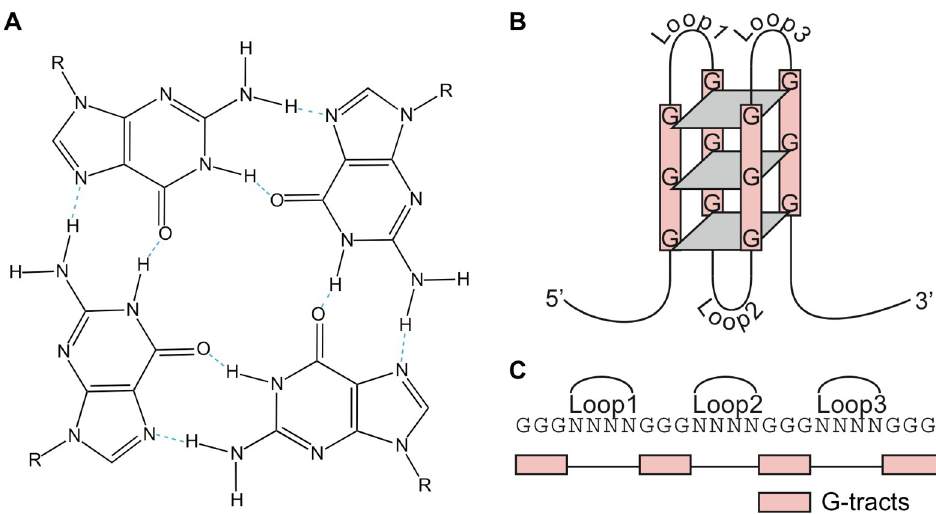
Fig 1. G-quadruplex (G4) structure. (A) Schema of a G-tetrad that makes up the core of a G4 structure, which are stabilized by coordination of an alkali cation (blue). (B) Schematic representation of a parallel unimolecular G4. (C) Example of a single-stranded DNA G4 motif, consisting of four G-tracts (pink), separated by three 4 nt-long loops. Figure adapted with permission from [12] under a CC BY